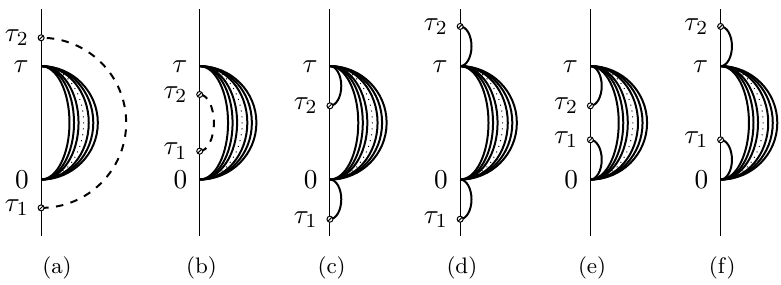
Figure 1 . Feynman diagrams contributing to E 0 and H bdry . The thin vertical lines are the Wilson paths while the thick lines are scalar propagators. The dashed line is both a scalar and a gluon propagator. Operators are positioned at 0 and (cid:28) . Small circular vertices are drawn in the scalar/gluon insertions of the Wilson